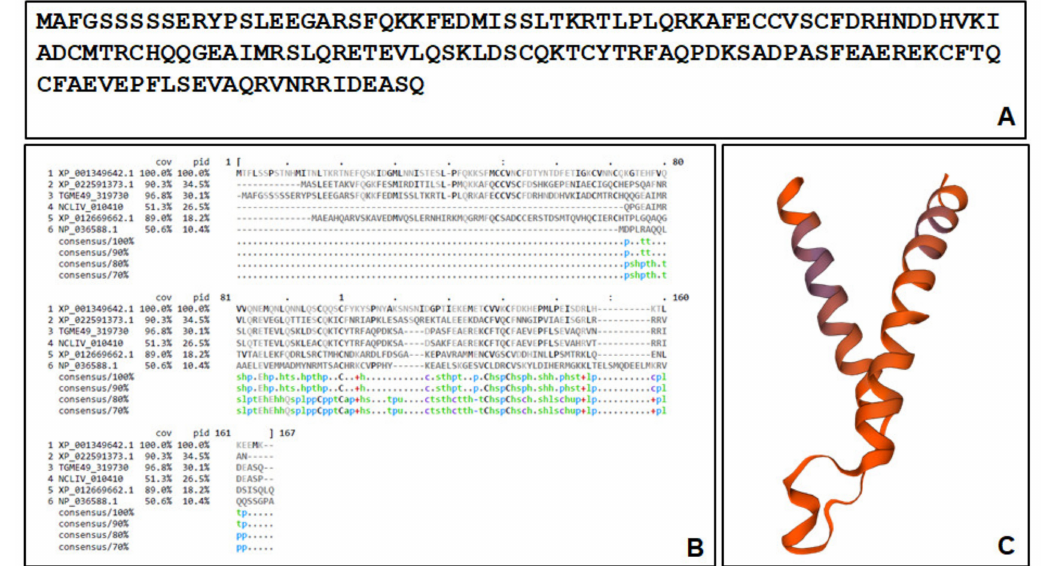
Figure 8. Deduced primary sequence of ORF TgME49_319730 is shown in ( A ). Alignments to five homologs and consensus sequences are presented in ( B ). Amino acid sequences are shown in grey, black amino acids indicate homologies or identities, from the consensus sequences, s, h and l are indicated in green, p in blue, ( C ) Model structure calculated from the mitochondrial import membrane translocase subunit Tim10 encoded by NP_036588.1 with hydrophilic residues depicted in violet and hydrophobic residues in orange.